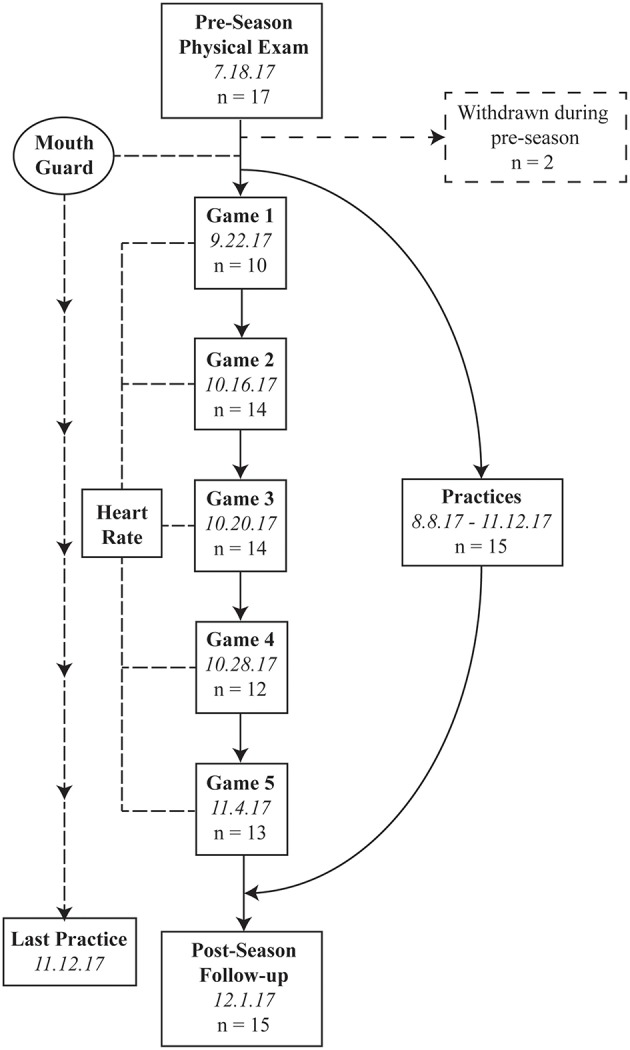
Study flow chart.